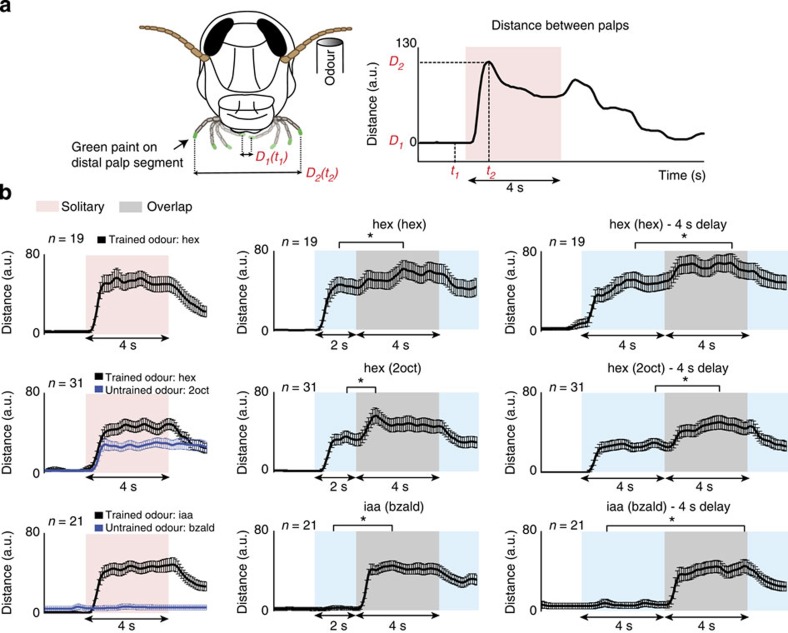
Behavioural responses to the conditioned stimulus are robust across presentation conditions.(a) A schematic of the locust palp-opening response (POR) assay. Opening of maxillary palps to the trained odourant was used as an indicator of acquired memory. The palps were painted with zero-volatile-organic-chemical green paint to facilitate tracking. The distance between the two palps on a frame-by-frame basis (100 ms temporal resolution) was calculated, smoothed and plotted as a function of time. (b) PORs tracked during test phase trials are shown for each type of stimulus presented (mean±s.e.m.). The conditioned stimuli (hex or iaa) were either presented alone (left column) or following another odourant with two different latencies: 2 s (middle column) or 4 s (right column). Responses to solitary presentations of the two untrained odourants (2oct and bzald) are plotted in blue in the leftmost column. Asterisks indicate significant increases in the peak POR elicited by the second stimulus (*P<0.05, Wilcoxon signed-rank test, n indicates the number of insects used in the test).